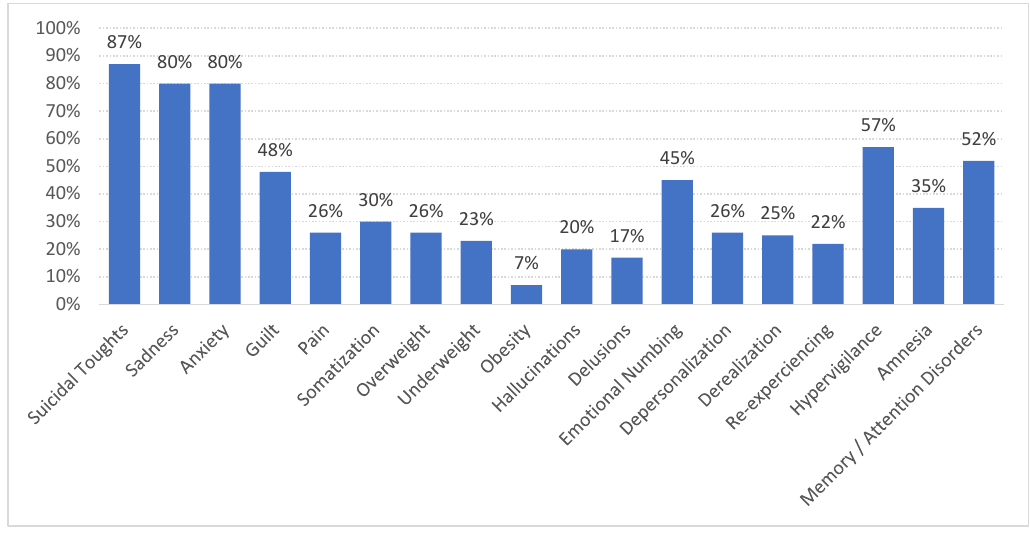
Int. J. Environ. Res. Public Health 2023 , 19 , x FOR PEER REVIEW Figure 1. Distribution of symptoms. Figure 1. Distribution of symptoms.